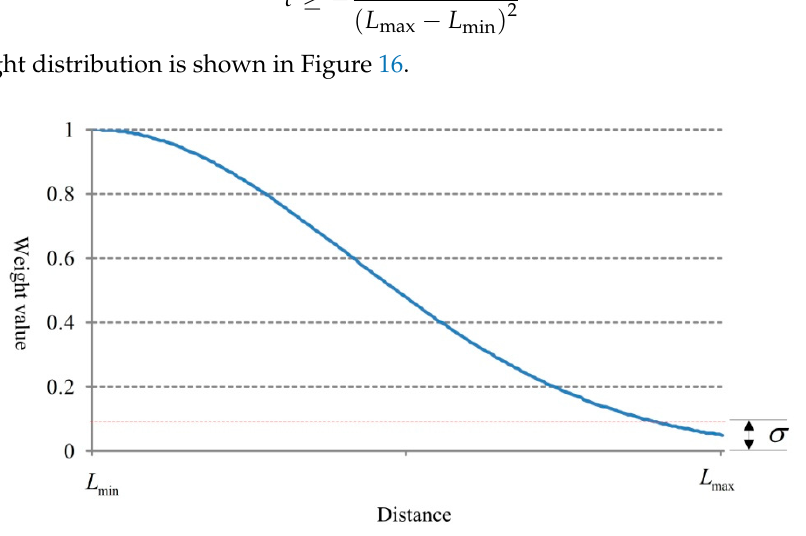
Figure 16. Weight distribution of the parameter series.